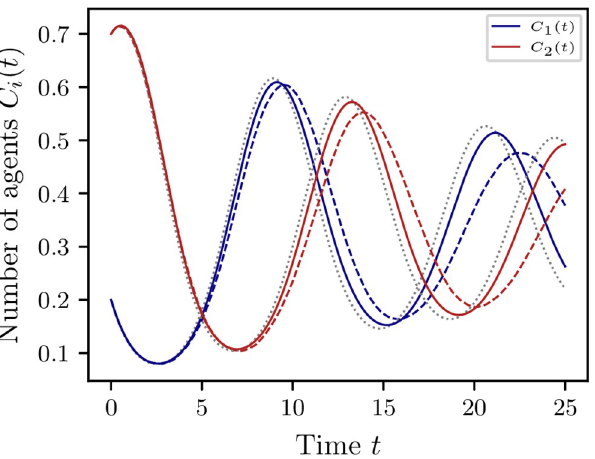
Fig 7. Prediction of extended voter model for random networks. Expectation of the data-driven reduced model (solid) compared the EVM (dashed) on a random network with average degree of approximately 50, estimated from 10 3 Monte Carlo simulations for N = 500 agents and initial state c ð 0 Þ ¼ ½ 0 : 2 ; 0 : 7 ; 0 : 1 � > 2 X . The deterministic part of the SDE limit model (5) is indicated in gray (dotted). The data-driven model is estimated using m = k = 1000 measurements and realizations for the lag time τ = 0.01.